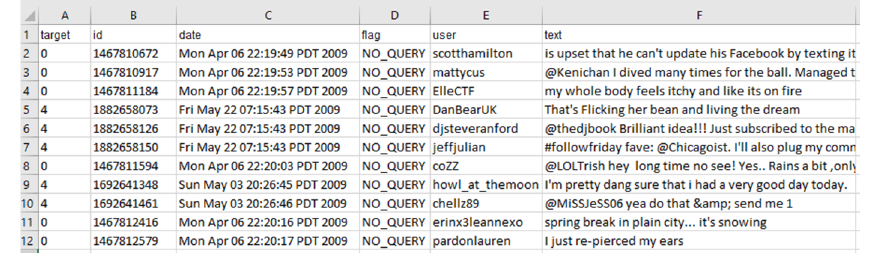
Figure 6. Examples of the Sentiment140 dataset.